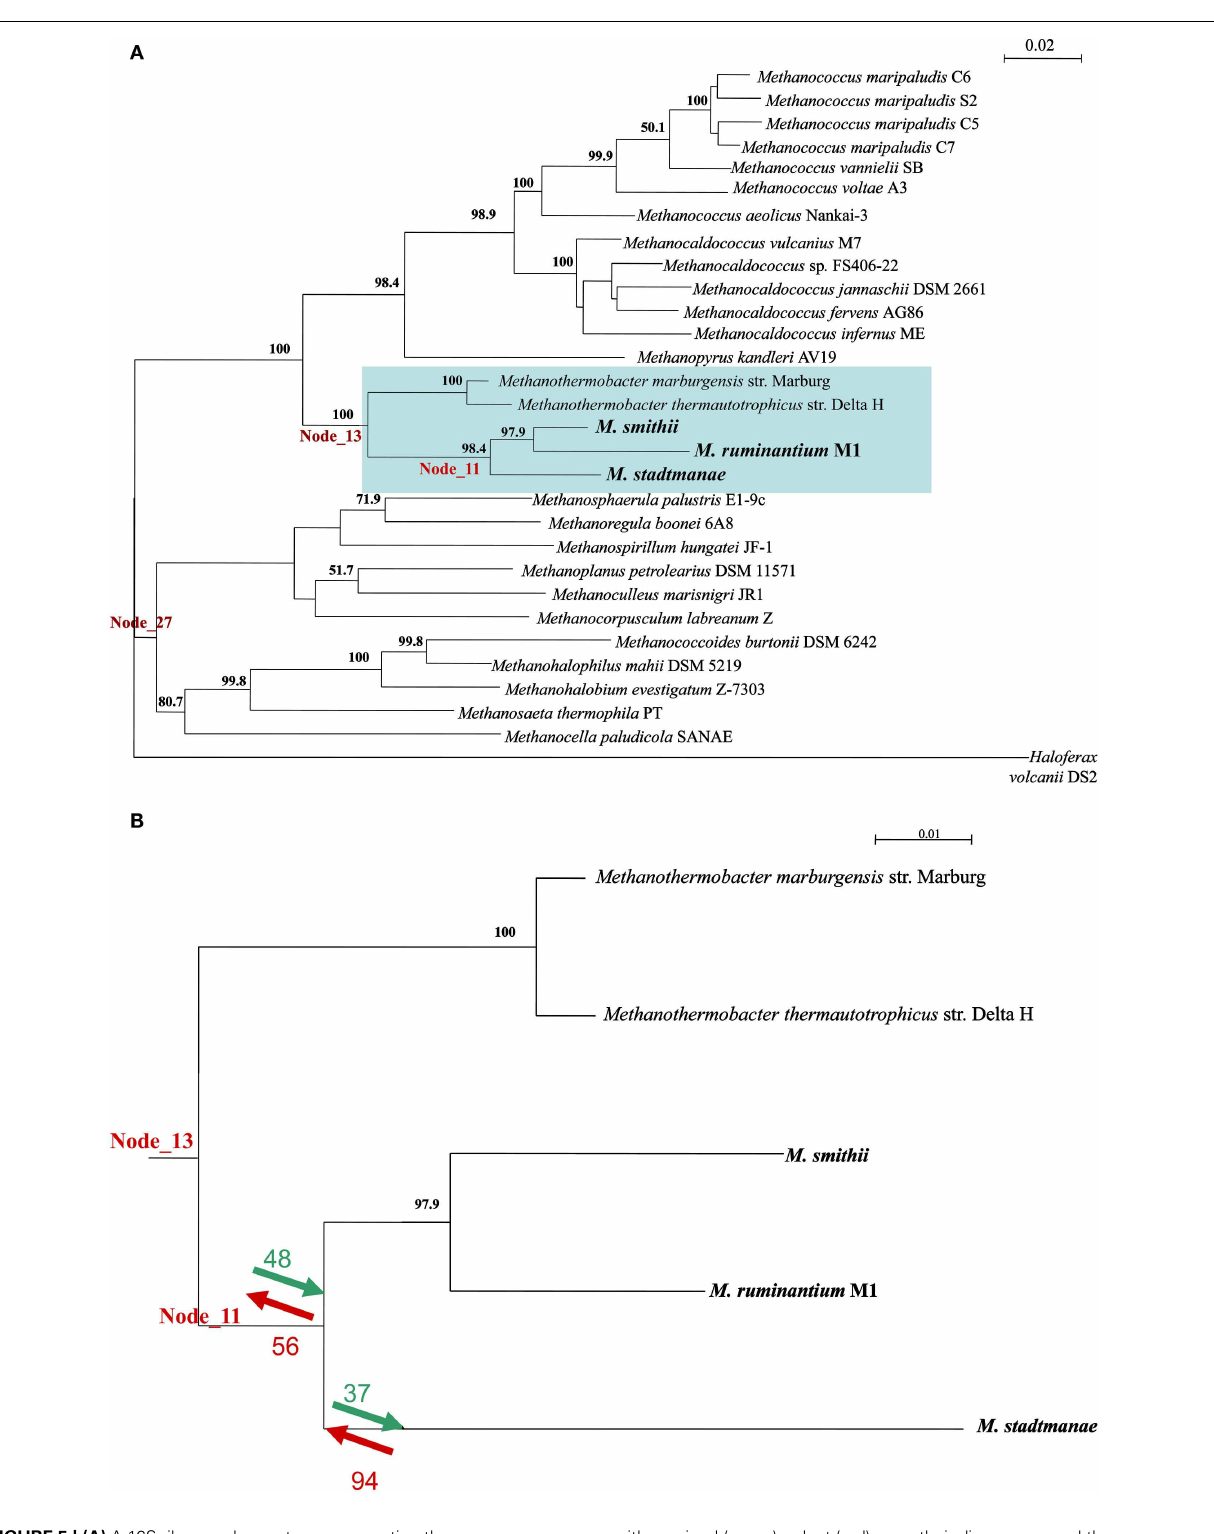
FIGURE 5 | (A) A 16S ribosomal gene tree representing the phylogenetic relationship between the Archaea in the ACE analysis. Numbers represent% of bootstrap support for nodes exceeding 50%. (B) The subtree representing nodes 11 and 13 and the COGs that were